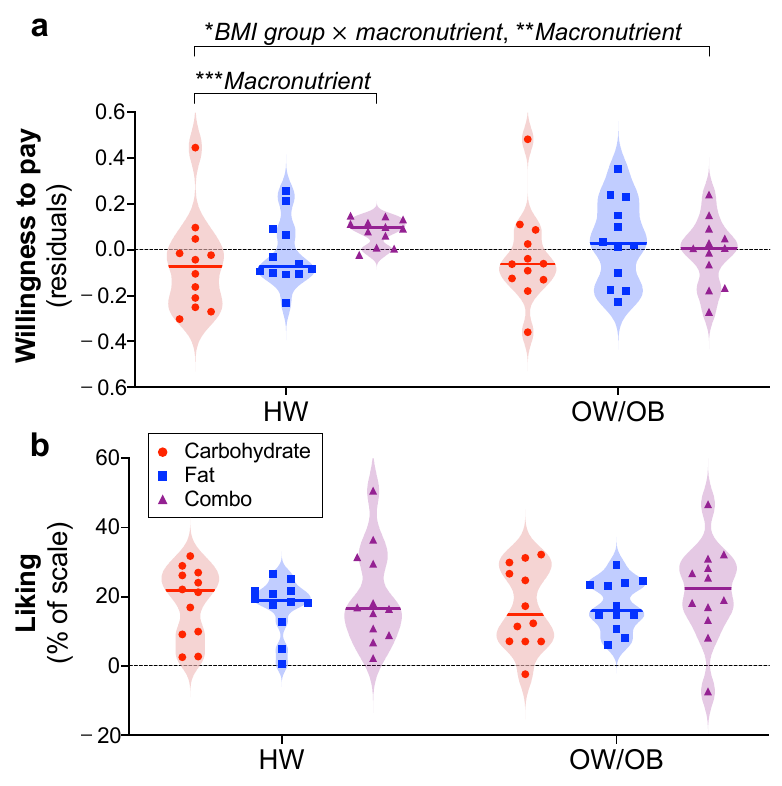
Figure 2. Effects of BMI group (HW, OW/OB) and macronutrient category (carbohydrate, fat, combo) on WTP and liking. ( a ) The interaction of BMI group × macronutrient category on WTP was significant (* p = 0.043), and there was an overall main effect of macronutrient (** p = 0.003) but no main effect of BMI group. This result was driven by a significant main effect of macronutrient category on WTP in the HW group (*** p = 0.001), but not in the OW/OB group. BMI groups did not differ in WTP for fat, carbohydrate, or combo foods. Residuals depict bids after accounting for covariates in the LMM: actual energy density, estimated energy density, estimated energy content, portion size, and liking. ( b ) No differences in the rated liking of the foods were observed across BMI group or macronutrient category, and there was no interaction of BMI group × macronutrient category on liking. Each data point depicts a single food item and shading represents the density of points around the